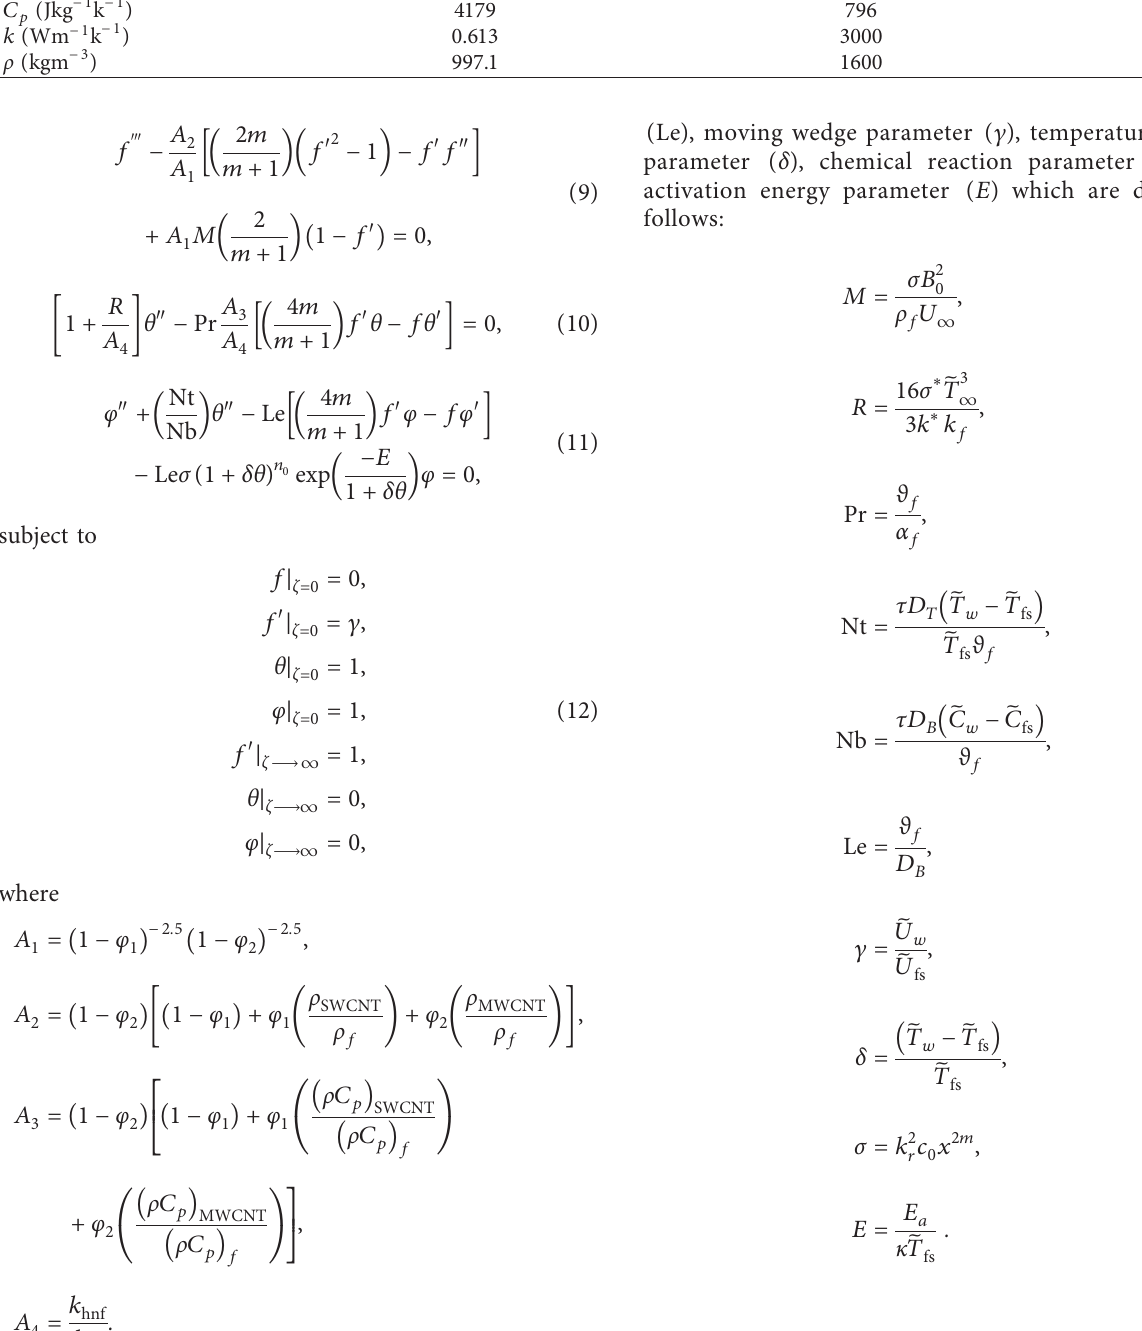
Table 1: Physical properties of base fluids ( H O ) and nanoparticles CNT s [19]. 2 Conventional fluid Property